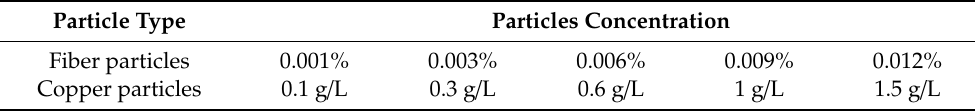
Figure 1. The optical microscope images of the copper particles ( a ) and fiber particles ( b ). Table 2. Particles concentration of experimental